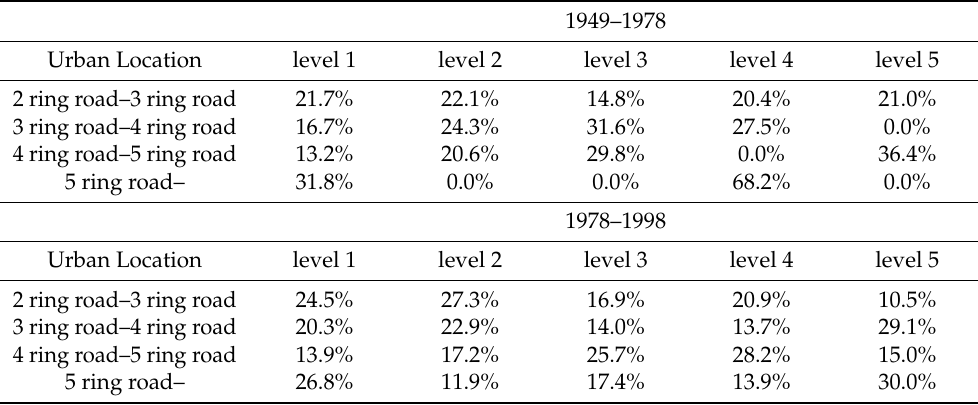
Table 6. Specific measurement results of the Green Space Distribution Coefficient